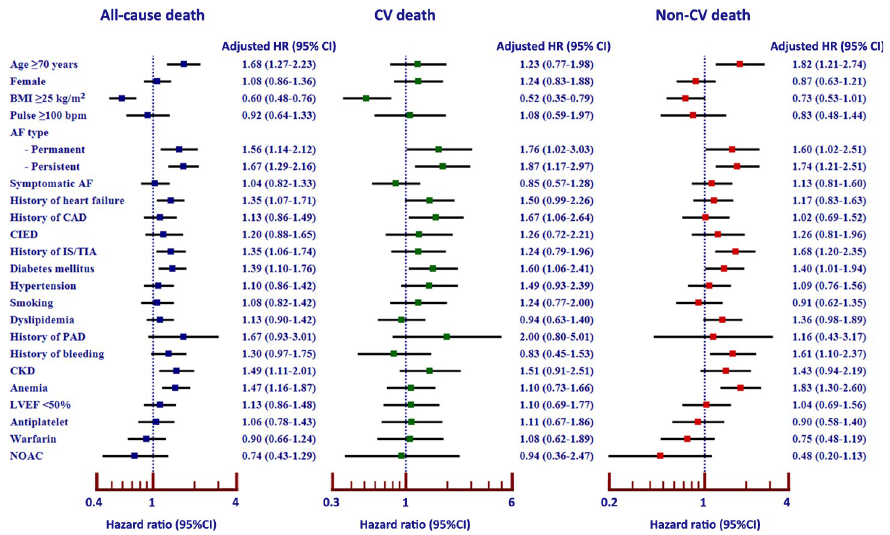
Fig 4. Forest plots showing the predictors of all-cause death, CV death, and non-CV death. ( Abbreviations: AF, atrial fibrillation; AMI, acute myocardial infarction; BMI, body mass index; bpm, beats per minute; CAD, coronary artery disease; CI, confidence interval; CIED, cardiac implantable electronic device; CKD, chronic kidney disease; CV, cardiovascular; HF, heart failure; HR, hazard ratio; ICH, intracranial hemorrhage; IS, ischemic stroke; LVEF, left ventricular ejection fraction; NOAC, non-vitamin K antagonist oral anticoagulant; PAD, peripheral arterial disease; SCD, sudden cardiac death; TIA, transient ischemic